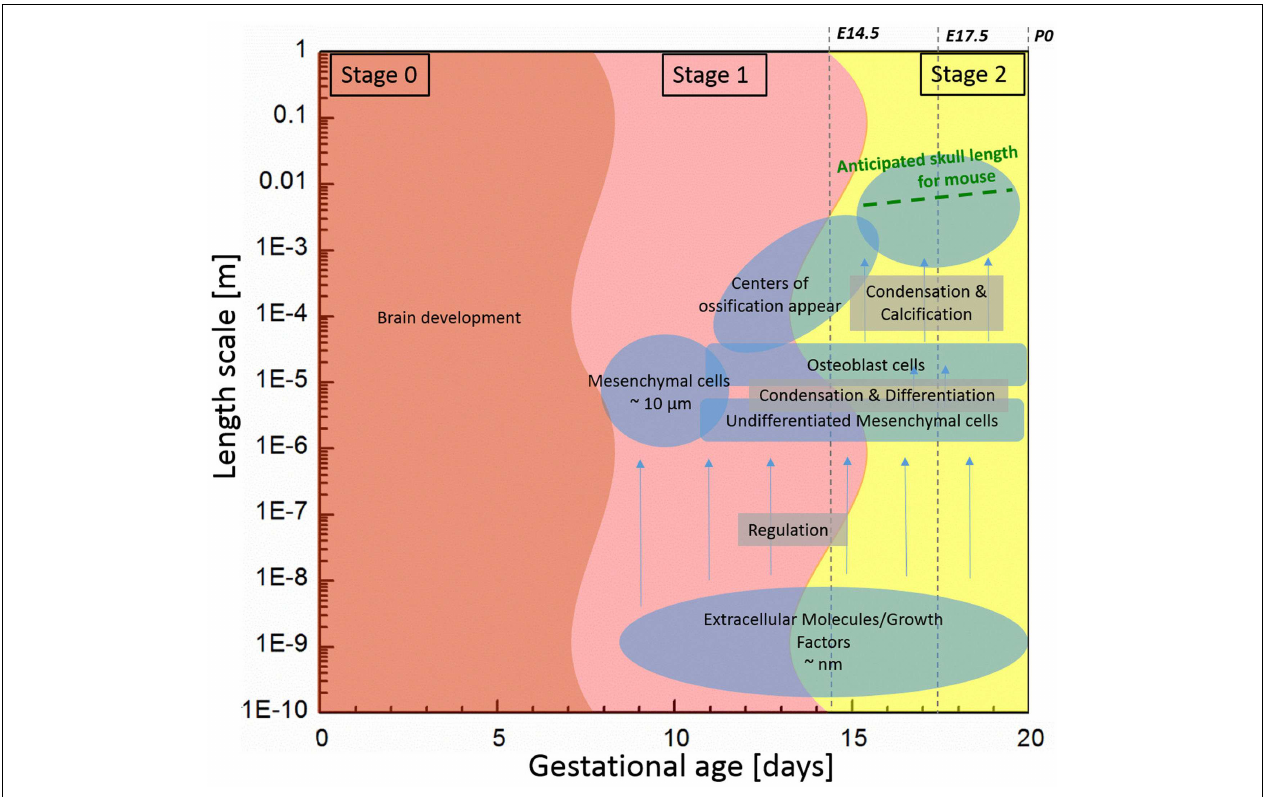
FIGURE 1 | Components associated with generalized mouse cranial vault bone development ranging from molecules to tissue according to time and length scale . Data are generated from observations of C57Bl6